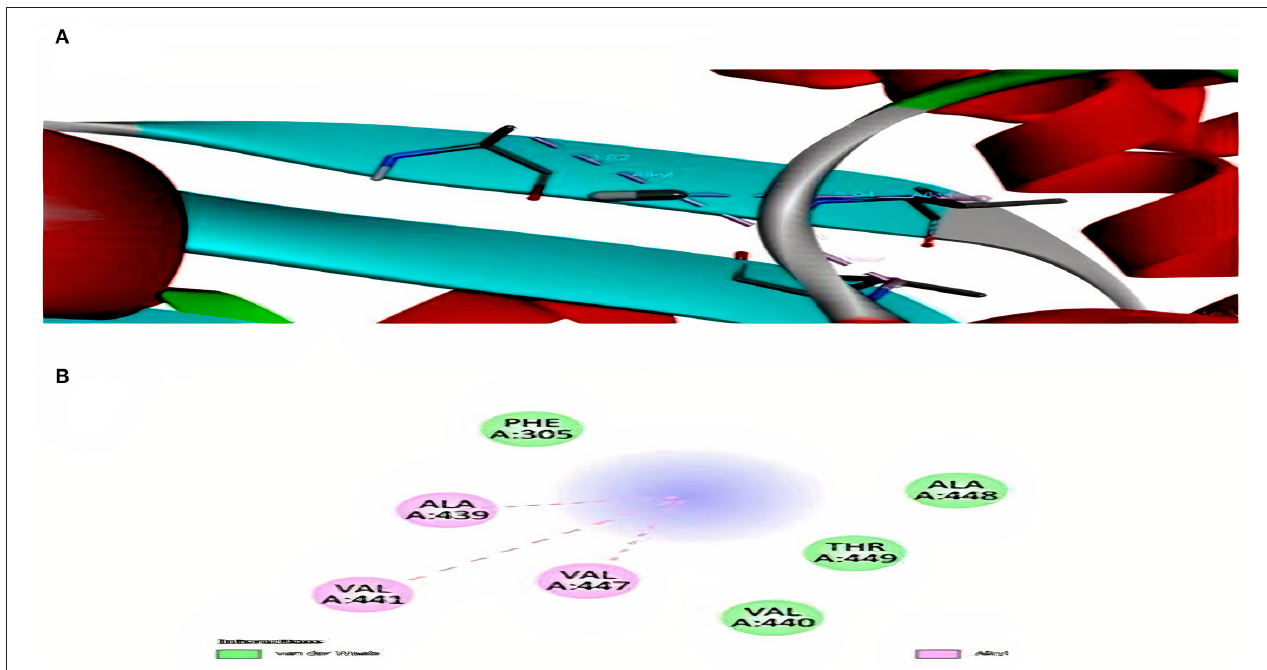
FIGURE 6 | (A) Interaction of methyl mercury with MerA protein. (B) 2D representation for interaction among alanine, valine, threonine, and phenylalanine.